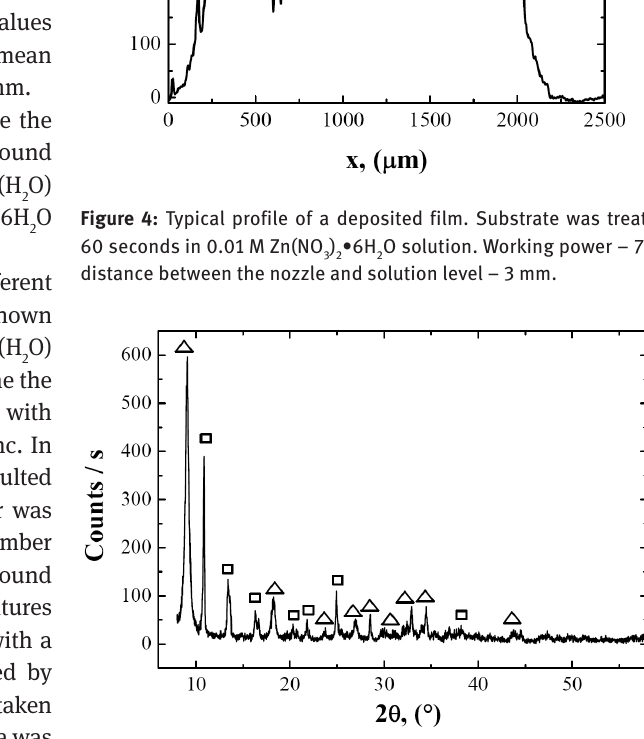
(OH) (NO ) (H O) ,  Zn(OH)(NO 5 8 3 2 2 2